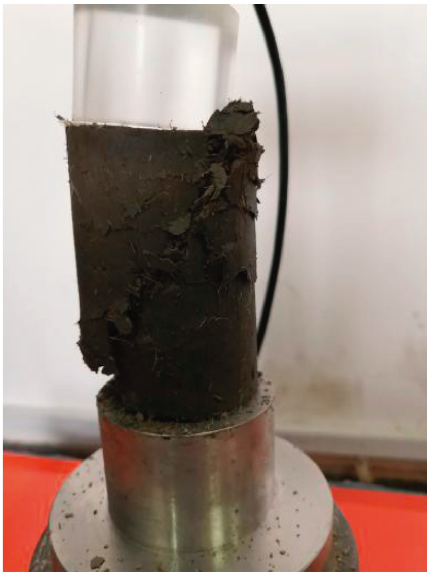
Figure 5: Failure mode of cement and fiber admixed slurry specimen with a cement content of 20% and a fiber content of 1%.